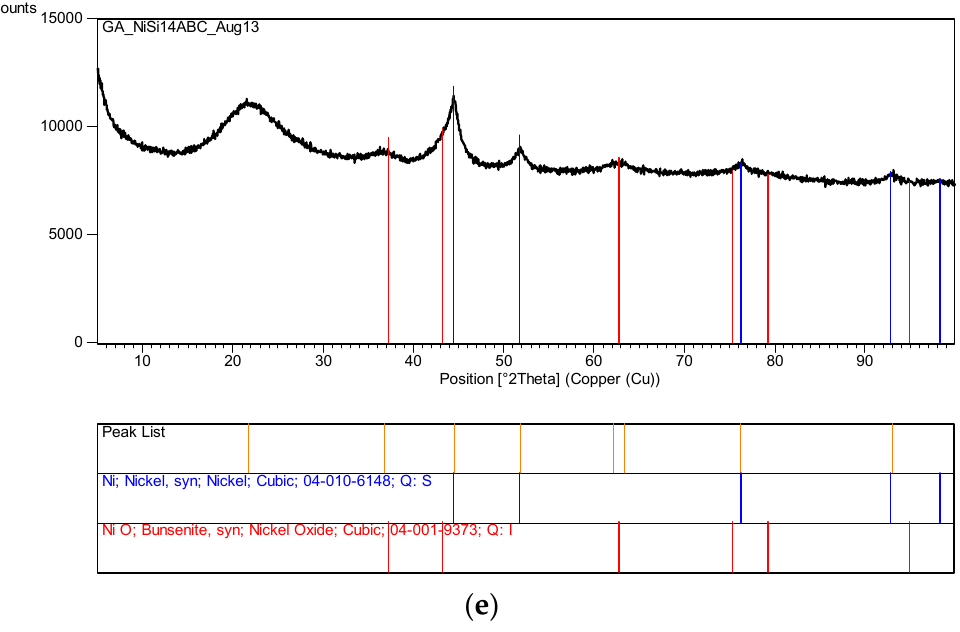
Figure 12. ( a ) XRD pattern of the sample Ni/Si = 1/4 Mw ‐ Y pH = 0.2: Nickel nitrate silica precursor fluid ([Ni]/[Si] = 1/4) microwaved at 1 kW but it was not fully decomposed because pH = 0.2. An alternative method is to stop the microwave radiation immediately after the start of decomposition and remove the green and black parts separately; ( b ) XRD pattern of the sample in Figure 12a [Coded as Ni/Si = 1/4 Mw ‐ YB pH = 0.2] after its heat treatment at 600 °C (1 h heating and 1 h dwell time followed by 24 h cooling in the furnace); ( c ) XRD pattern of the catalyst precursor dispersion/solution (Sample Ni/Si = 1/4 Mw ‐ A; pH = 5.5) after it was microwaved at 1 kW forming a black supported nickel oxide; ( d ) XRD pattern of the sample Ni/Si = 1/4 Mw ‐ AB from Figure 12c when the microwave irradiated catalyst precursor dispersion/solution at pH = 5.5 was subjected to heat treatment at 600 °C; ( e ) XRD pattern of silica supported nickel catalyst (Ni/Si = 1/4 Mw ‐ ABC) after the reduction process by hydrogen using the sample in Figure 12d.